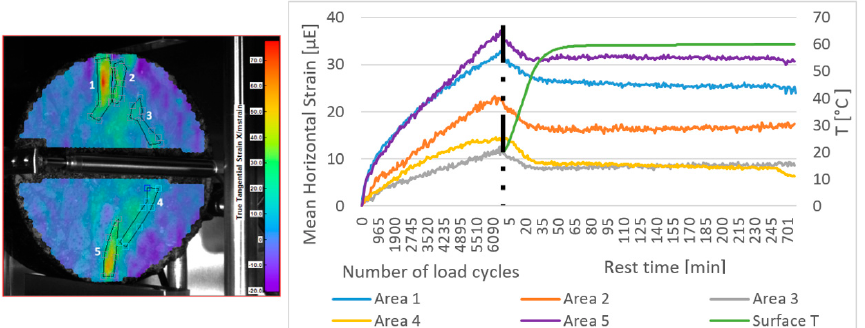
Figure 6. Horizontal strain of specimen S1 at the end of step 1 ( left ), and the mean horizontal strain of five selected areas( right ), the vertical dash-dot line shows the stopping moment of step 1 and start of step 2.